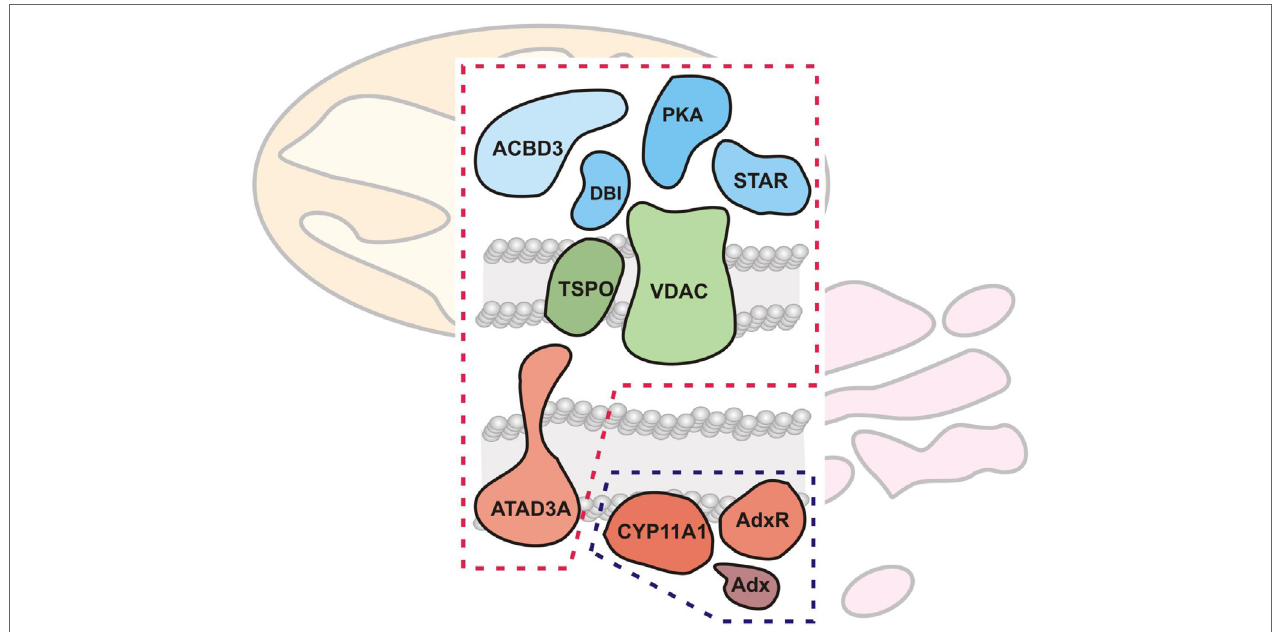
FiGURe 5 | Mitochondrial cholesterol transport and metabolism machinery . The mitochondrial cholesterol import and metabolism machinery are shown, demarcated by red (transduceosome) and blue (metabolon) dashed lines, respectively. The transduceosome contains cytoplasmic (StAR, ACBD3, DBI, and PRKARI; colored blue), OMM (VDAC and TSPO; colored green), and IMM (ATAD3A; colored red) components which assemble in response to hormonal stimulation and transduce the resultant cAMP signal to the mitochondria for cholesterol import. It is important to note, however, that molecular details of cholesterol import are still lacking. Once cholesterol is imported into the mitochondria, the IMM metabolon (CYP11A1, FDX, and FDXR; colored red) metabolizes cholesterol to pregnenolone, the precursor to all other steroids, including adrenal glucocorticoids and